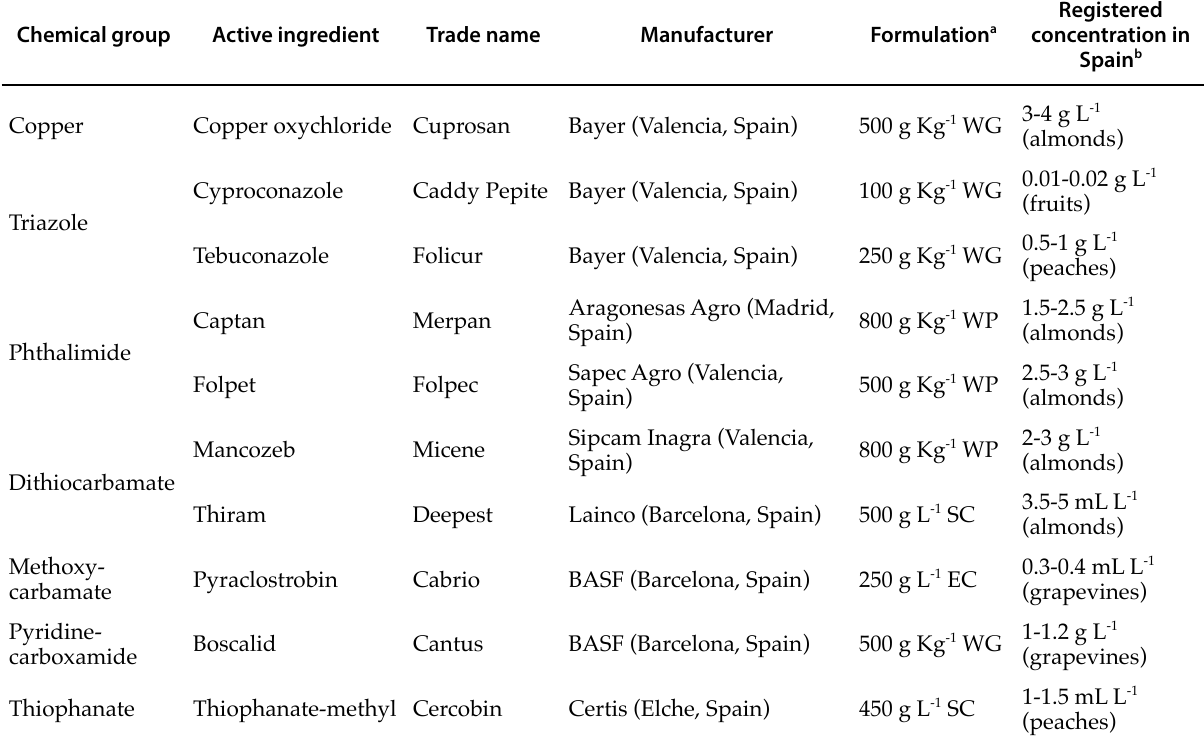
Table 1. Fungicides assessed for in vitro activity against four Botryosphaeriaceae pathogens of